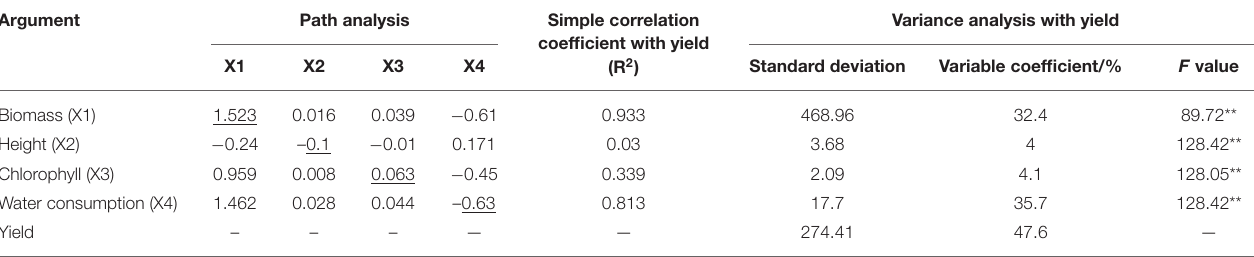
TABLE 6 | The decomposition of the simple correlation coefficient and analysis of variance of agronomic